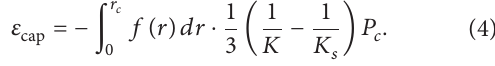
radius (if it exists before reaching equilibrium) would result in a gradient of capillary pressure, which further induces water movement until equilibrium is restored. As RH